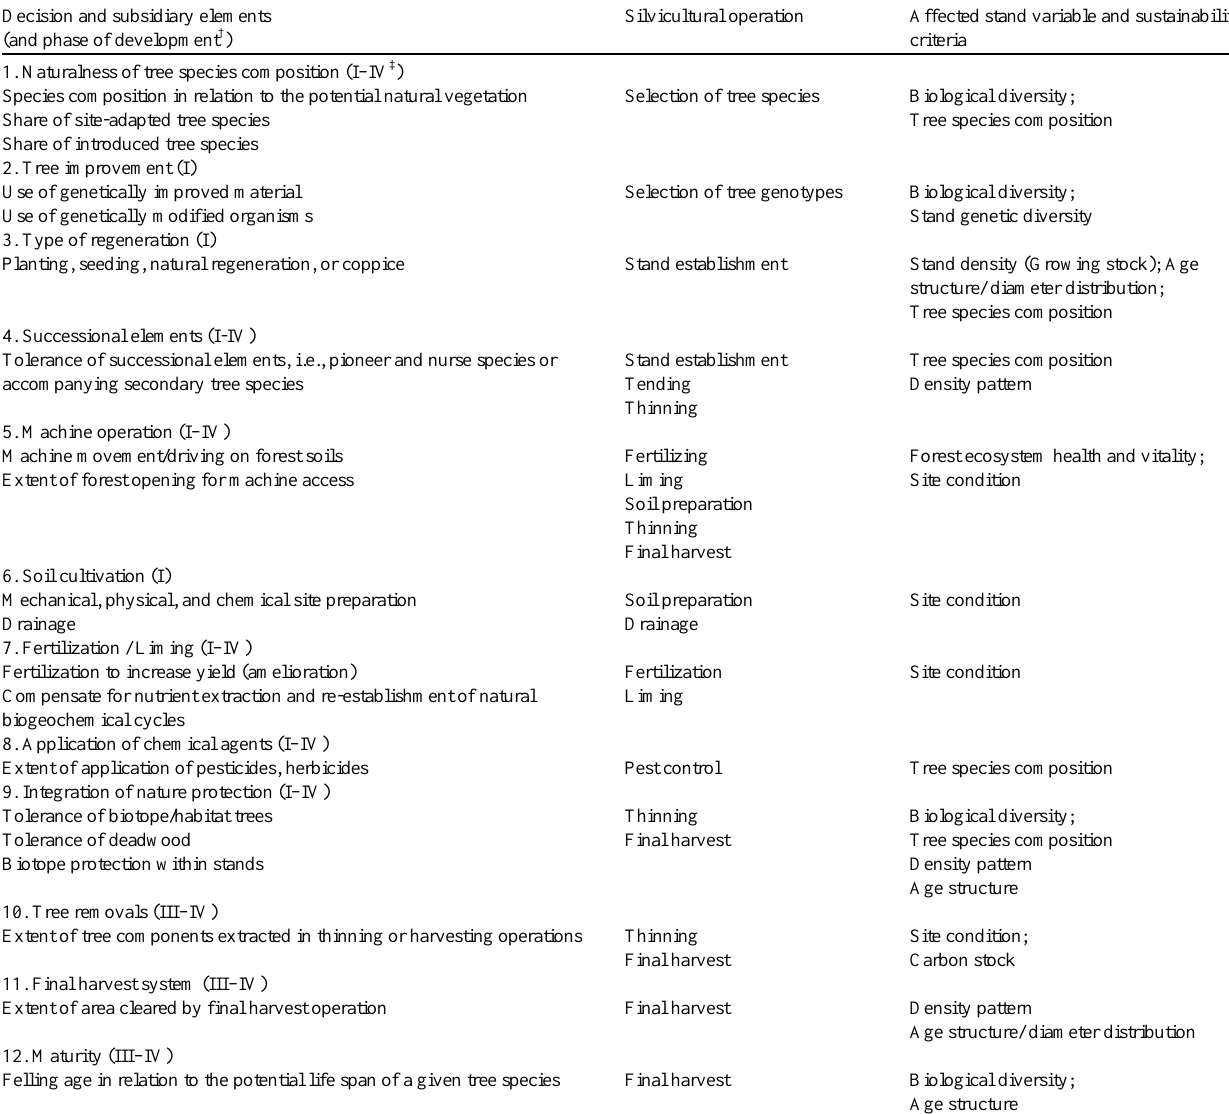
Table 1. Major decisions involved in forest management, the associated silvicultural operations, and the link to sustainability